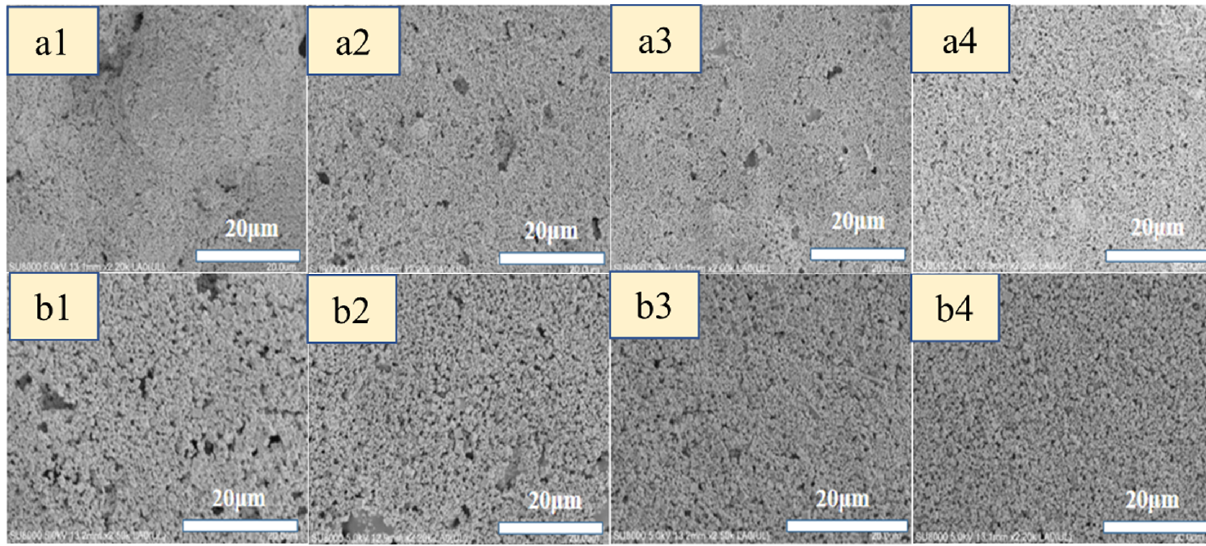
Figure 8. Surface morphology of the ITO ( a1 : 37 μm, a2 : 15 μm, a3 : 4 μm, a4 : 400 nm) and In 2 O 3 ( b1 : 37 μm, b2 : 15 μm, b3 : 4 μm, b4 : 400 nm) films obtained using different glass powder particle sizes.